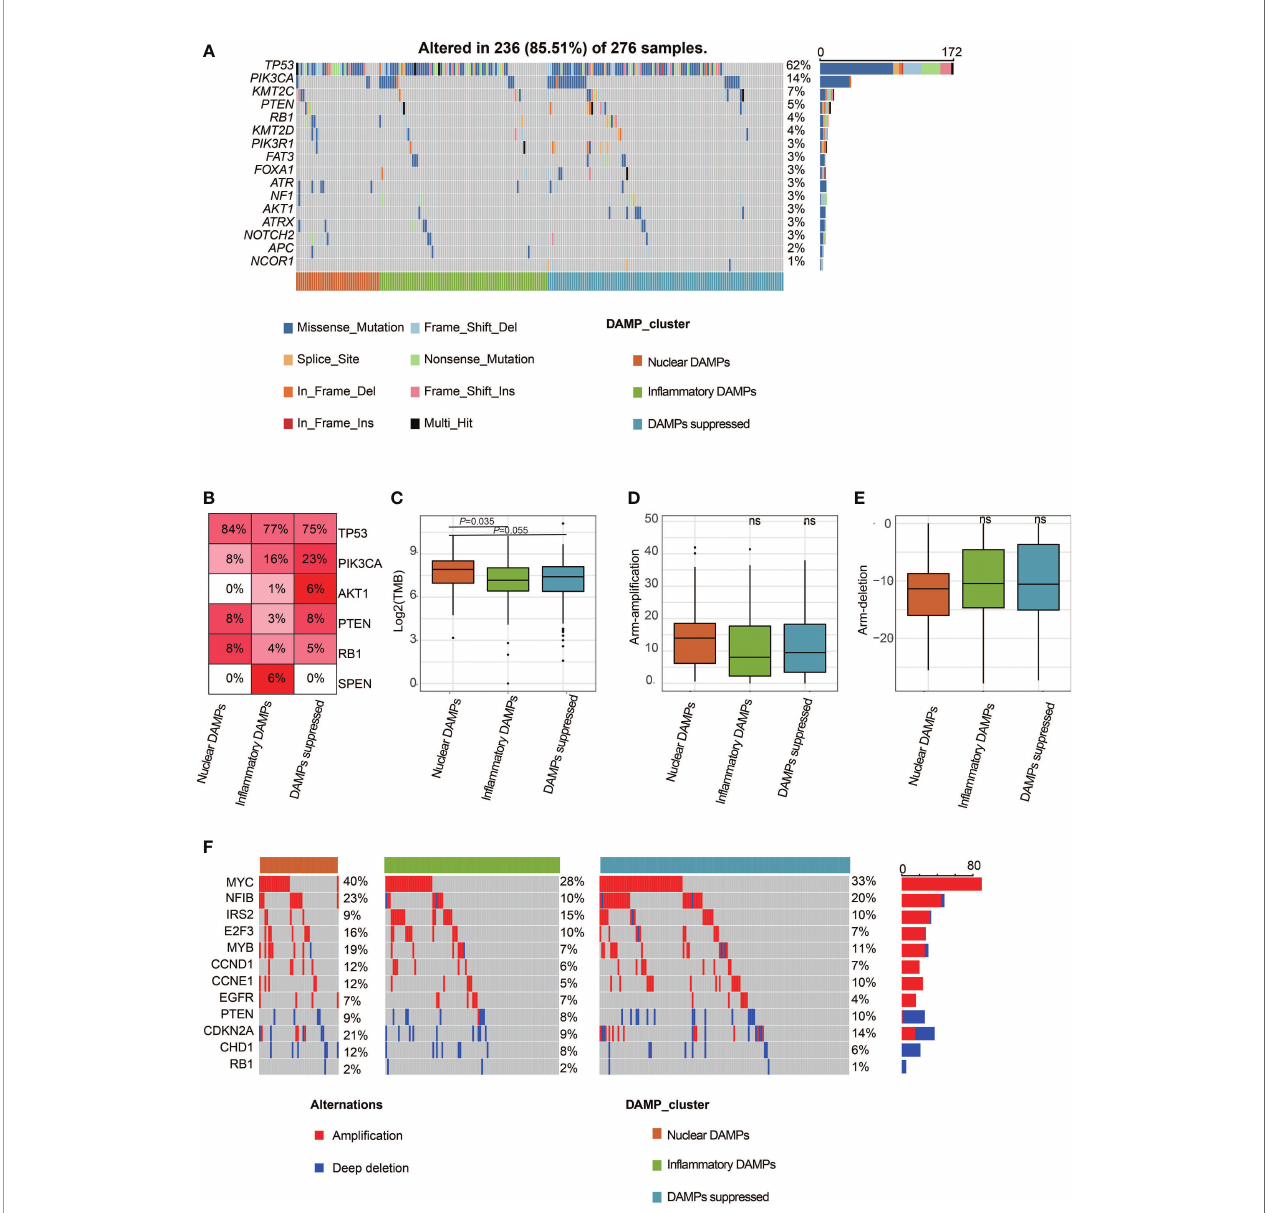
FIGURE 4 | Comparison of genomic alterations of DAMPs-associated subtypes in the FUSCC-TNBC cohort. (A) Differential somatic mutation analysis among the three subgroups. (B) Somatic mutation percentage of mostly mutated genes. (C) Tumor mutant burden difference among the three subtypes in the FUSCC cohort. (D) Arm-level copy number ampli fi cation in DAMPs-associated subtypes. (E) Arm-level copy number deletion in DAMPs-associated subtypes. (F) Distinct CNA pro fi le among the three subgroups. ns, not signi fi